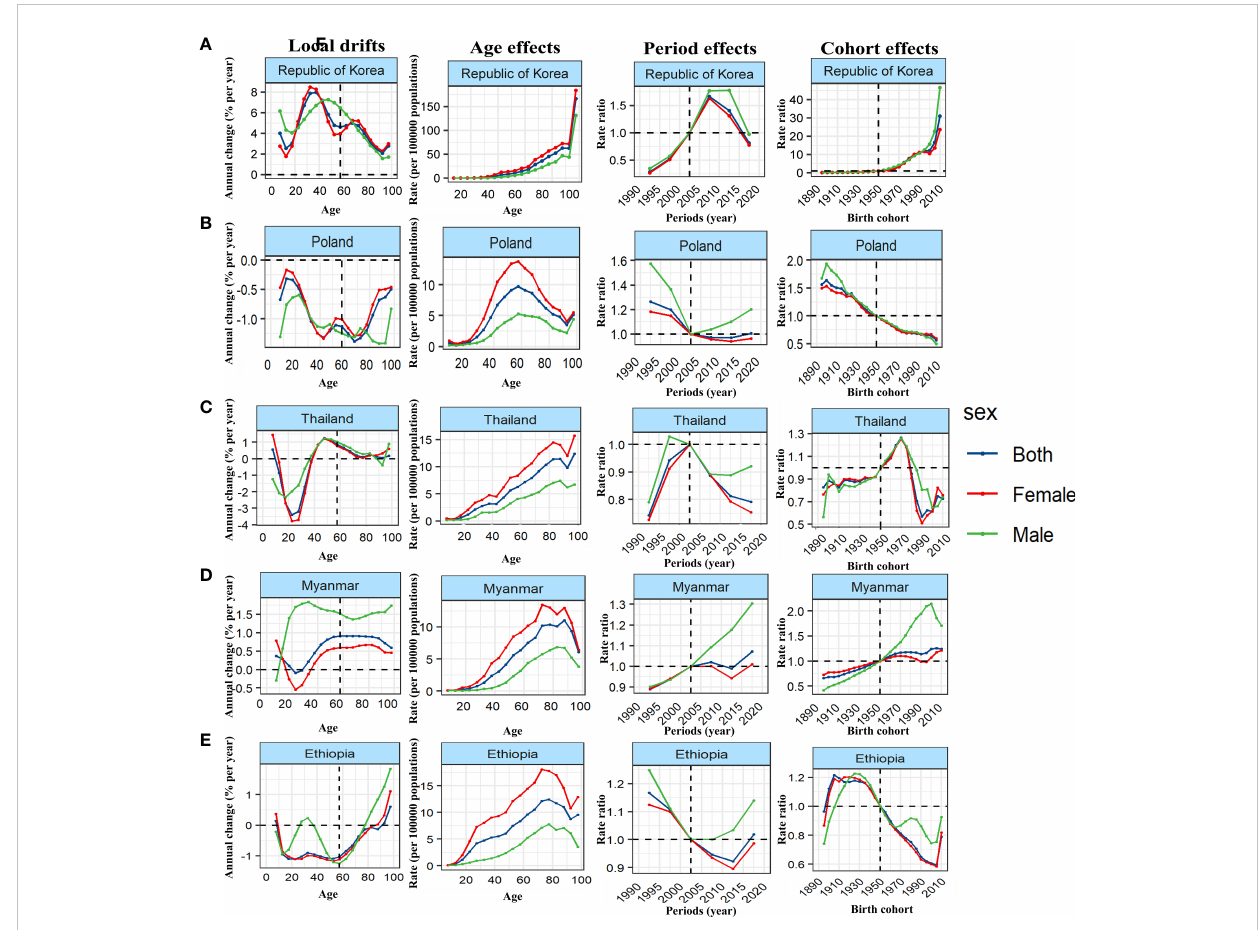
FIGURE 5 Favourable APC effects on exemplar countries across (A) high-, (B) high-middle, (C) middle, (D) middle-low and (E) low-SDI countries. Local drifts indicate the annual percentage change of incidence (% per year) across fi ve-year age groups (from 5 to 9 to 95 plus years). Age effects are represented by the fi tted longitudinal age curves of incidence (per 100,000 person-years) adjusted for period deviations. Period effects are represented by the relative risk of incidence (incidence rate ratio) and computed as the ratio of age-speci fi c rates in each period compared to the referent period. Cohort effects are represented by the relative risk of incidence (incidence rate ratio) and computed as the ratio of age-speci fi c rates in each cohort compared to referent 1950